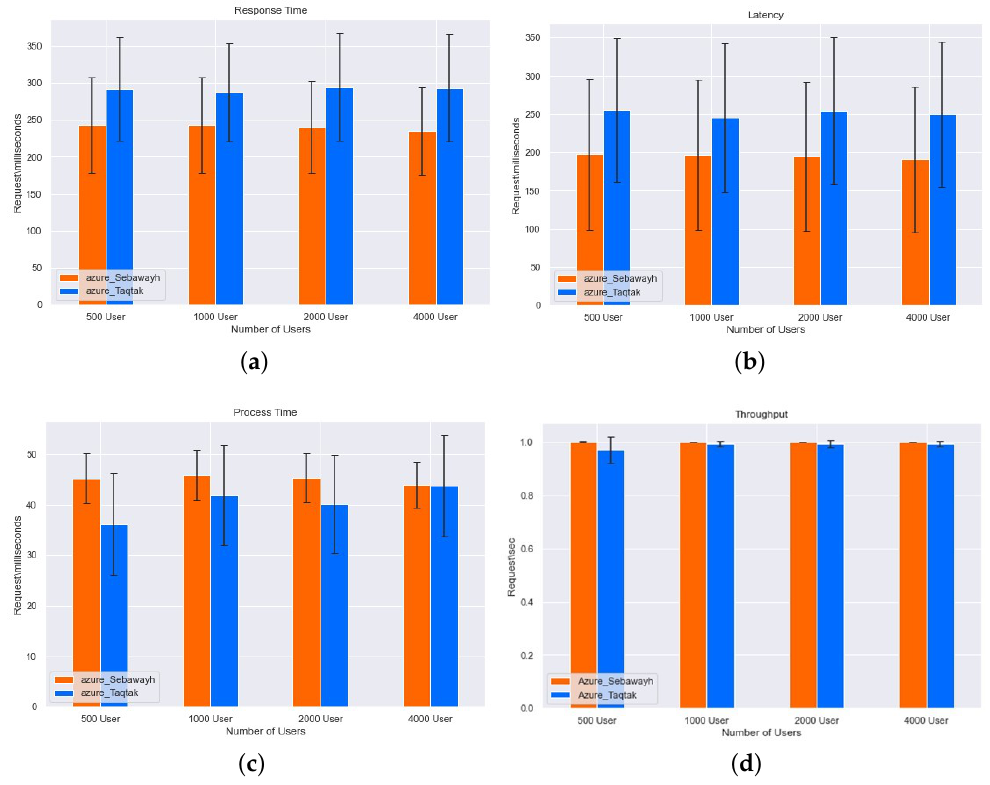
Figure 3. Results for different cloud-API-based applications on Microsoft Azure. ( a ) Response time of both APIs on Azure. ( b ) Latency of both APIs on Azure. ( c ) Processing time of both APIs on Azure. ( d ) Throughput of both APIs on